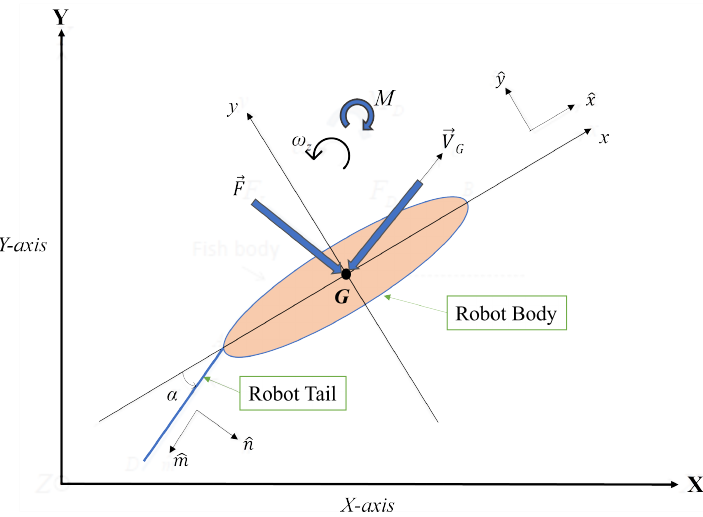
Figure 8. Top view of robotic fish in Cartesian coordinate system undergoing planar